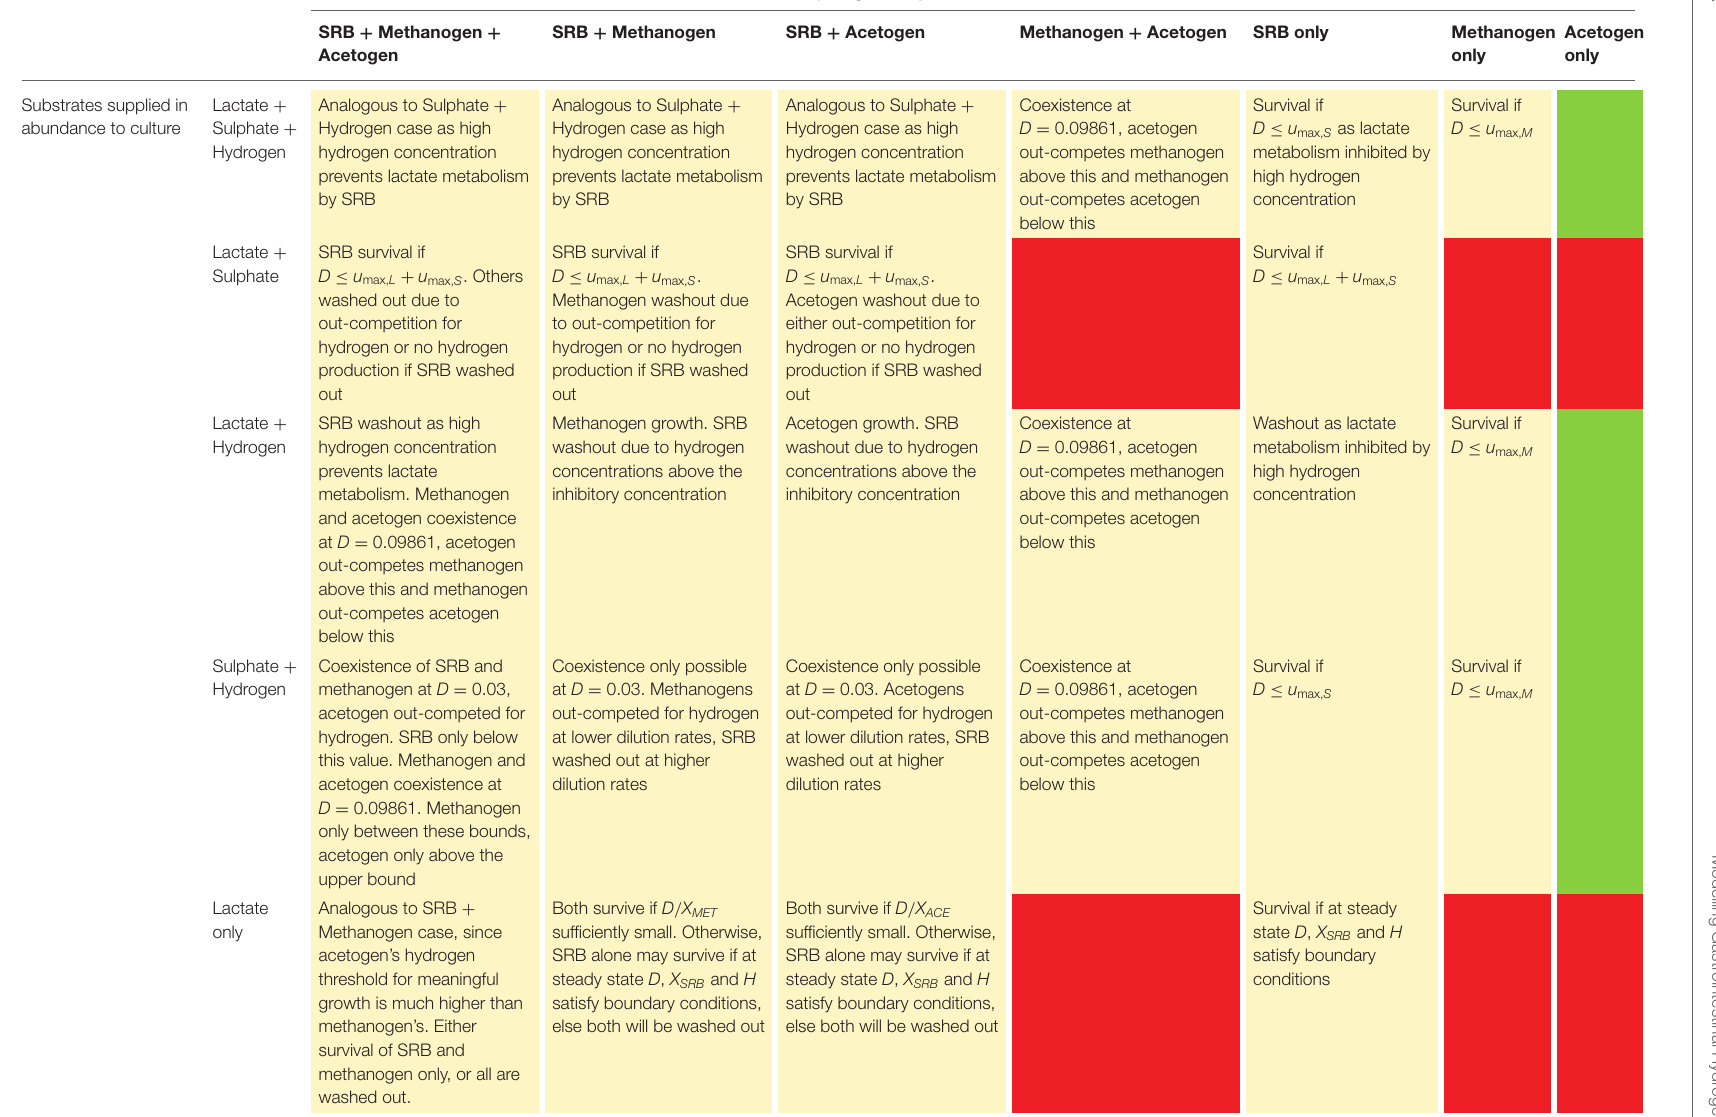
TABLE 3 | Outcomes of continuous culture under various